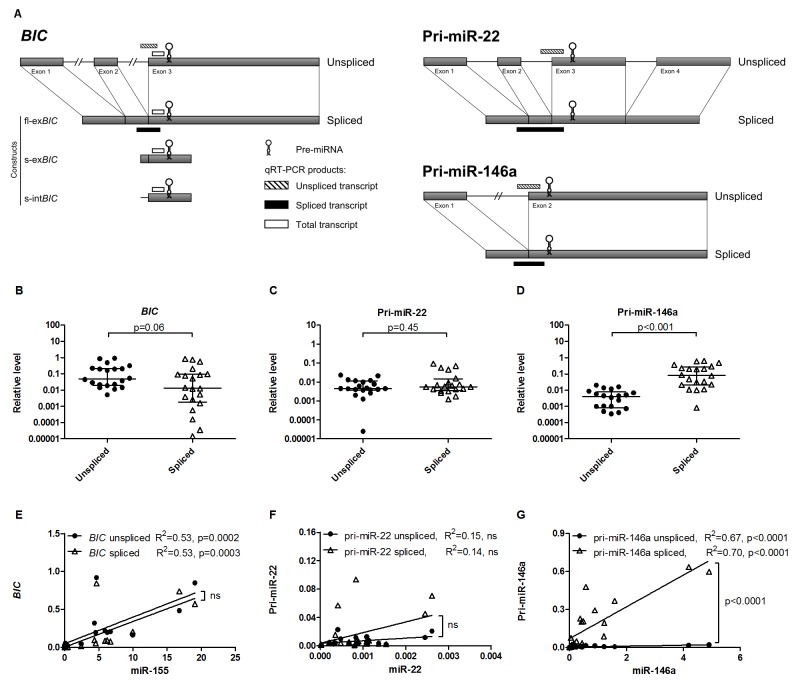
The unspliced/spliced transcript ratio is miRNA-specific in B-cell lymphoma.(A) Schematic overview of the unspliced and spliced BIC, pri-miR-22 and pri-miR-146a transcripts and location of the qRT-PCR products specific for unspliced, spliced and total (only for BIC) transcripts. Constructs used for miR-155 overexpression are also denoted. Short constructs, s-exBIC and s-intBIC, contain the pre-miR-155 sequence and ~150nt 3’ flanking sequence from exon 3 and 5’ flanking sequence derived from exon 2 (s-exBIC) or intron 2 (s-intBIC) of BIC transcript. The fl-exBIC construct covers the full-length spliced BIC transcript. Figures are not drawn to scale. (B) The median endogenous level of unspliced BIC transcript (0.049) was 3.7 fold higher than level of spliced BIC transcript (0.013). (C) The median endogenous level of unspliced pri-miR-22 (0.004) was similar to level of spliced pri-miR-22 (0.006). (D) The median endogenous unspliced pri-miR-146a level (0.004) was 20.5 fold lower than that of spliced pri-miR-146a (0.081). Levels of BIC, pri-miR-22 and pri-miR-146a were assessed in 20 B-cell lymphoma cell lines and normalized to HPRT levels. Significance was tested with Mann-Whitney test. (E) Both spliced and unspliced BIC showed a similar significant correlation with miR-155 levels. (F) Neither of the two pri-miR-22 transcripts showed a significant correlation with the miR-22 levels. (G) Both unspliced and spliced pri-miR-146a levels significantly correlated with the miR-146a levels. However, the slope of the regression line was significantly steeper for spliced pri-miR-146a.